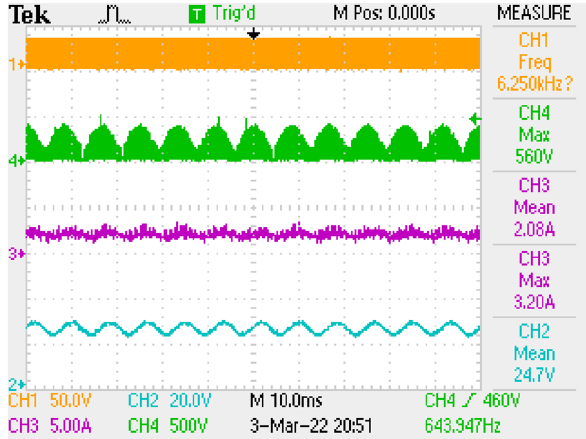
Figure 16. By LC with parallel damping DM filter, (zoomed of Fig. 15).